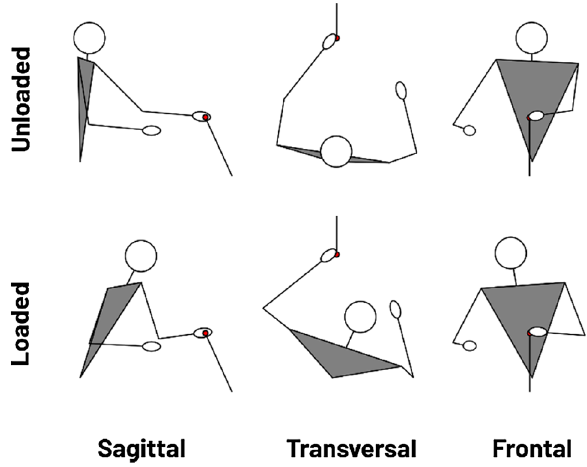
Figure 3. Final posture of a typical participant in the spontaneous condition as a function of load (Unloaded: top row, Loaded: bottom row). Diagrams are viewed from the side (sagittal plane, left column), viewed from above (transverse plane, middle column) and viewed from the front (frontal plane, right column). The red circle represents the target. When the hand is loaded, the participant has less elbow extension, less shoulder flexion and shoulder abduction at the expense of greater trunk flexion and rotation. The figure shows that the greater recruitment of the trunk brings the shoulder closer to the target, resulting in less gravitational torque at the shoulder, as can be inferred by comparing the sagittal